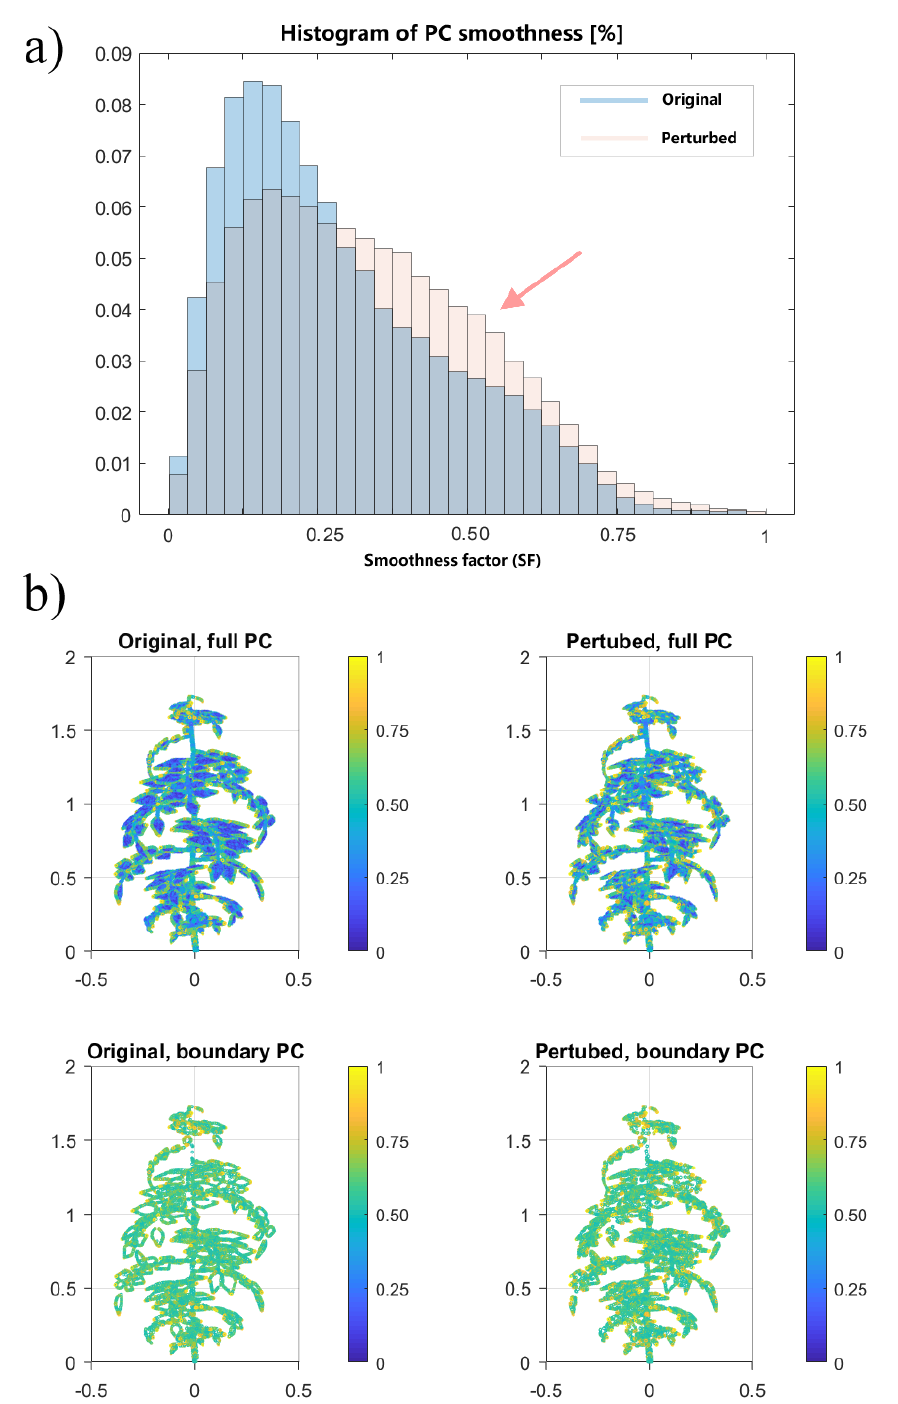
Figure 12. Example of analysis and visualization of smoothness of tomato point clouds (PC). ( a ) His- tograms of smoothness factor (SF) from Equation (1)) of original and randomly perturbed tomato point clouds. The arrow in the histogram plot indicates the elevation of amount of corner/edge points with a larger smoothness factor (SF) in the randomly perturbed model. ( b ) Visualization of original vs. randomly perturbed full and boundary point clouds of the tomato plant. Boundary points were detected using the smoothness factor values larger than 0.5. The colour map indicates the SF values ranging in [ 0, 1 ]